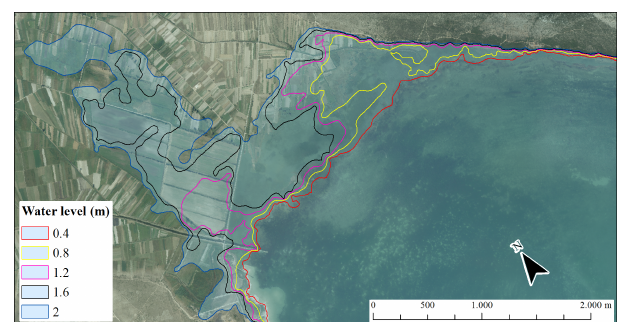
Figure 11. Annual water level oscillation in the northern part of Lake Vrana Nature Park (probable scenario in case the Jasen water pump stops